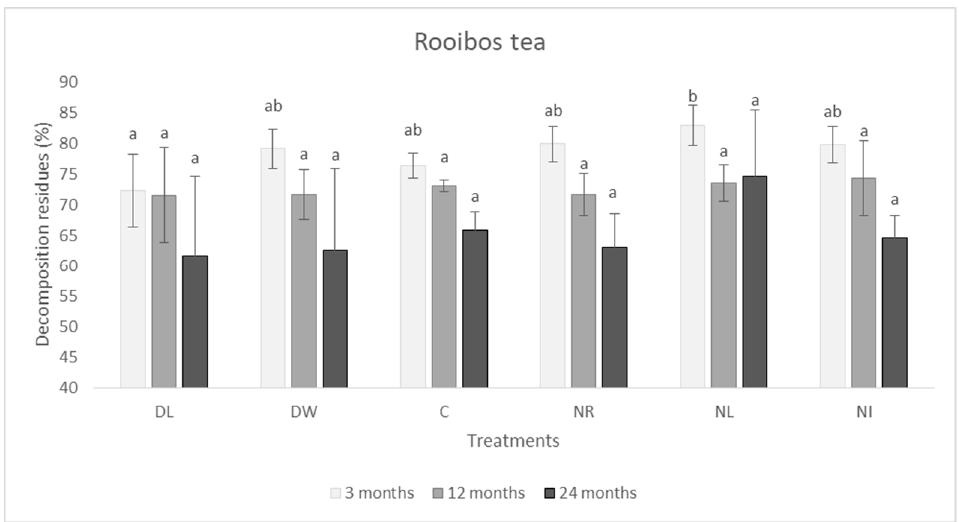
Figure 6. Effect of organic matter manipulation experiments with different DIRT treatments on rooibos tea degradation rate after 3, 6 and 12 months: The letters represent significant differences between treatments during the given period ( n = 4).